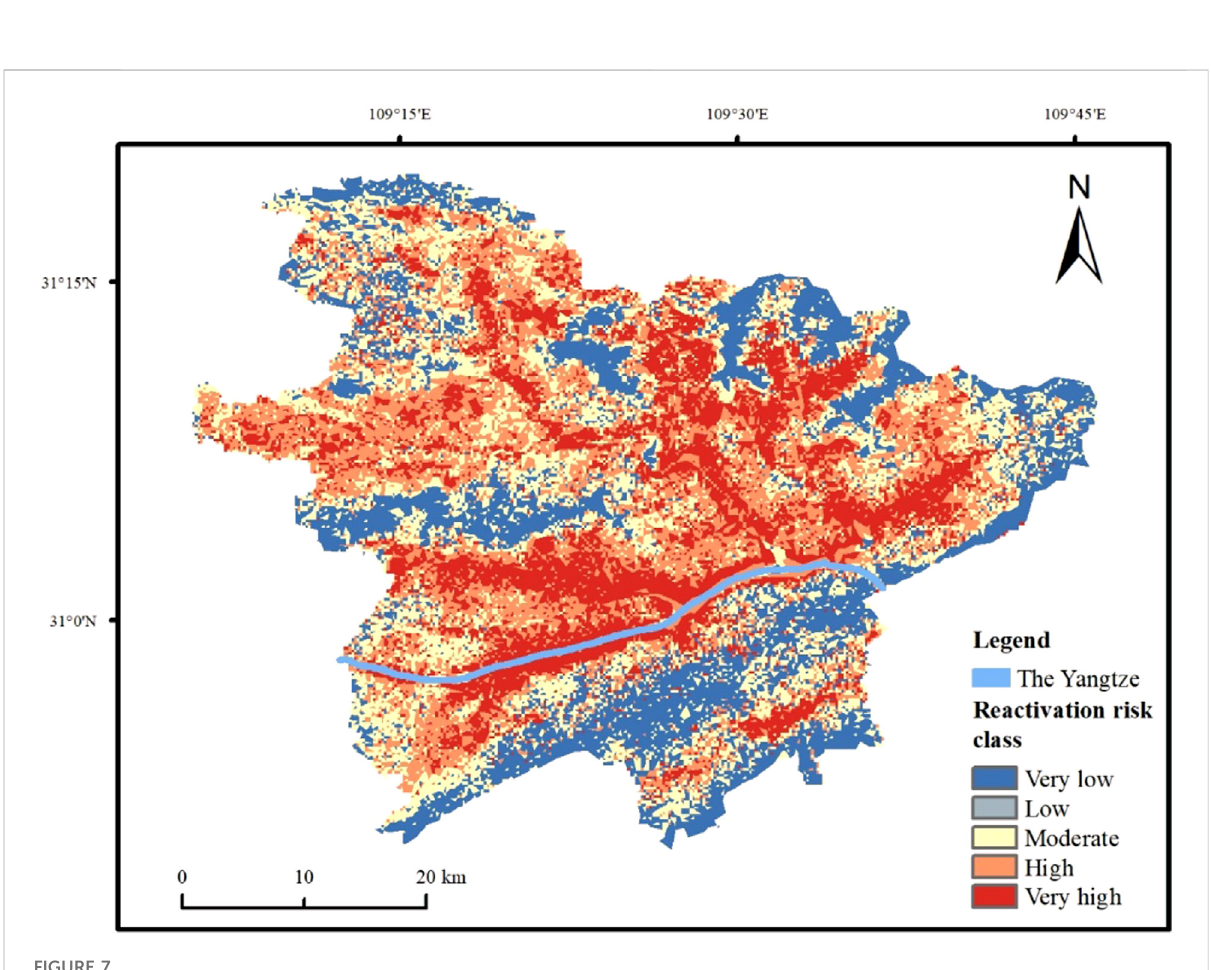
FIGURE 7 Landslide risk map based on joint response